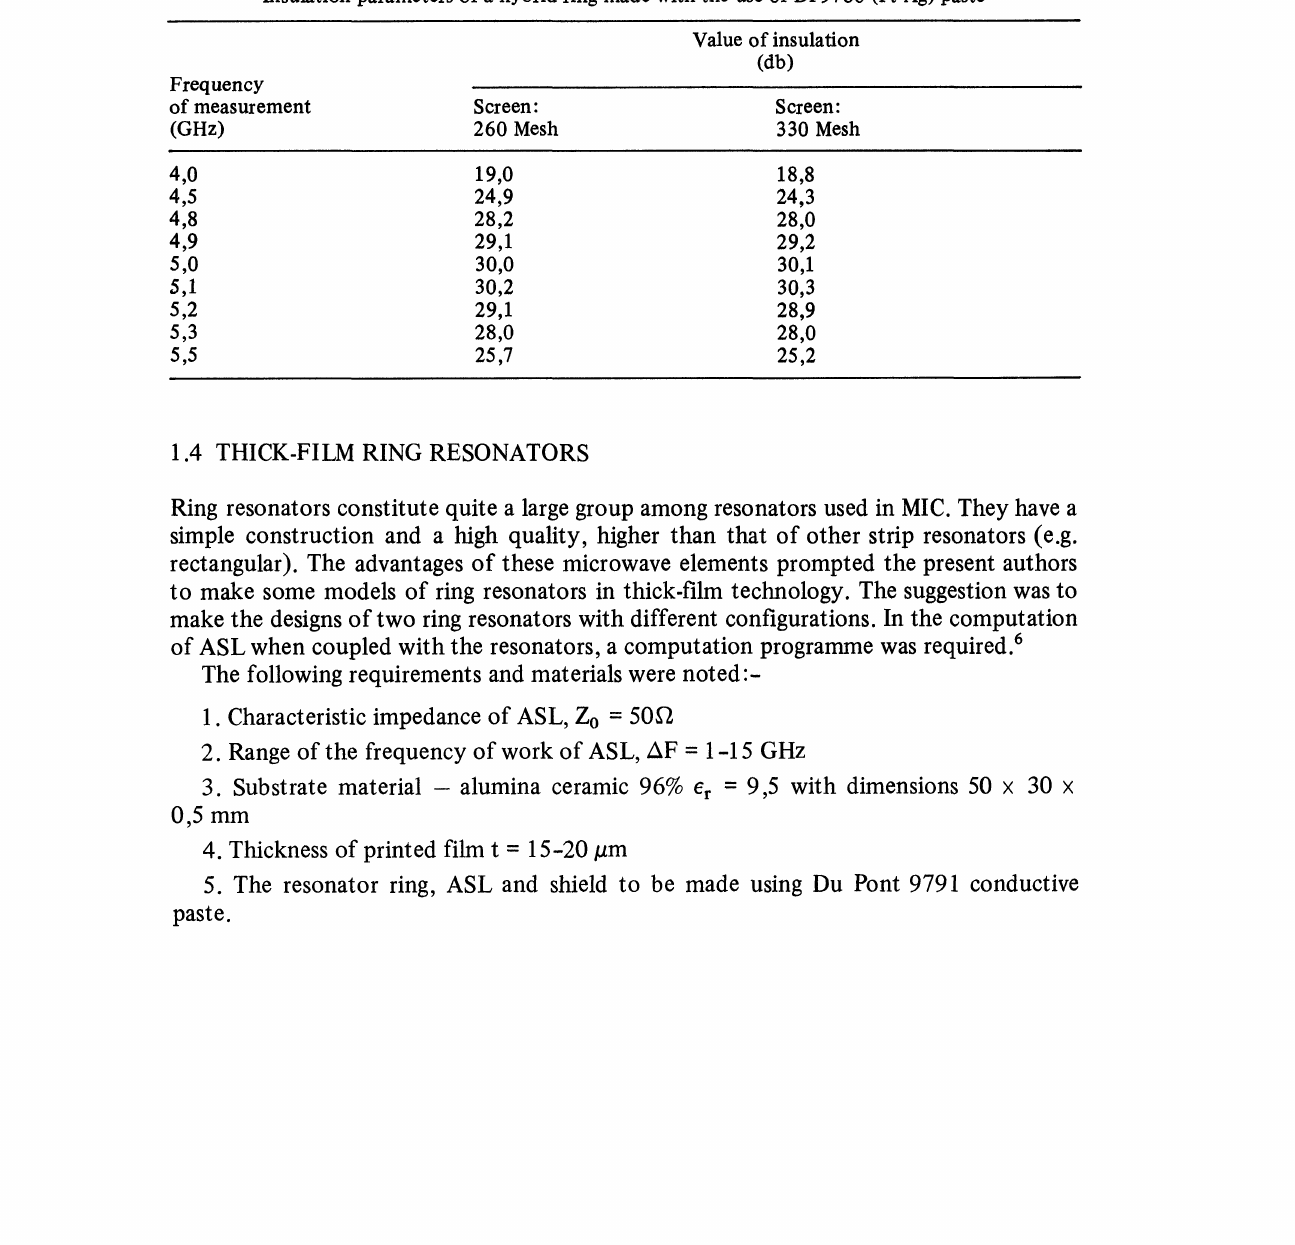
TABLE IV Insulation parameters of a hybrid ring made with the use of DP9780 (Pt-Ag)